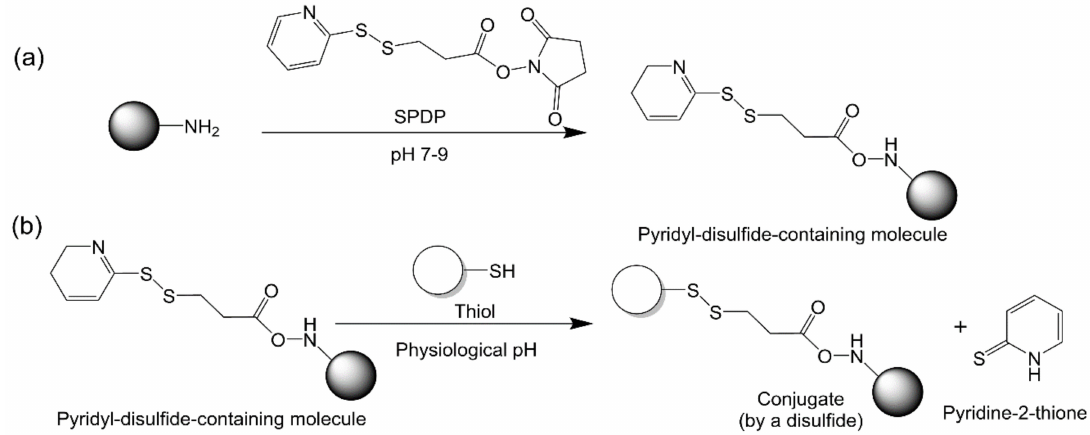
Figure 9. Thiol–disulfide exchange. ( a ) Functionalizing compounds with a pyridydithiol group. ( b ) Thiol–disulfide exchange between a thiol-containing compound and a pyridydithiol-containing